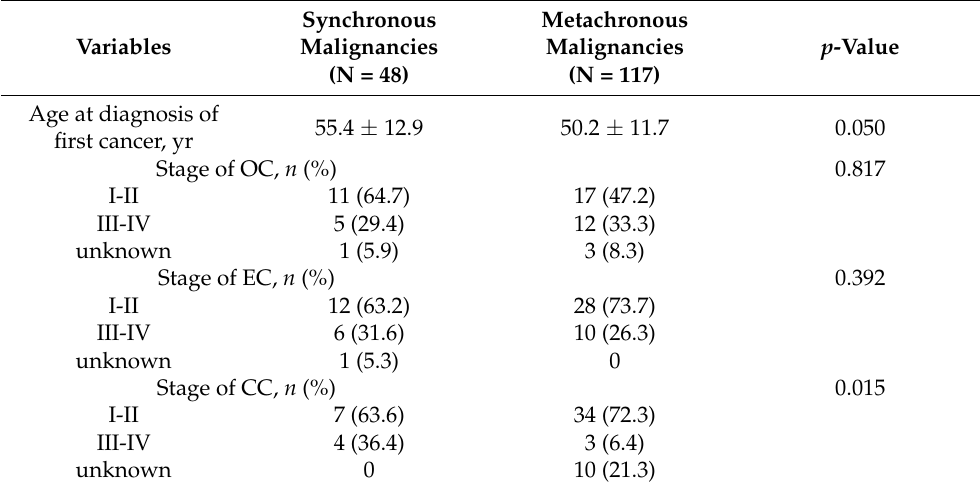
Table 2. Patient characteristics compared between synchronous malignancies and metachronous ma- lignancies.